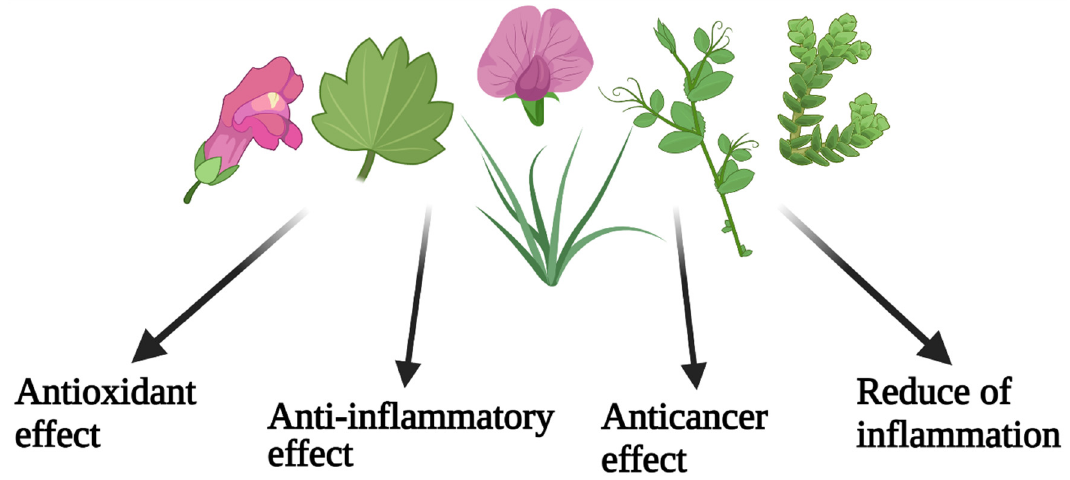
Figure 3. Schematic figure presenting the possible mechanisms of plant-derived compounds in order to treat psoriasis disease.